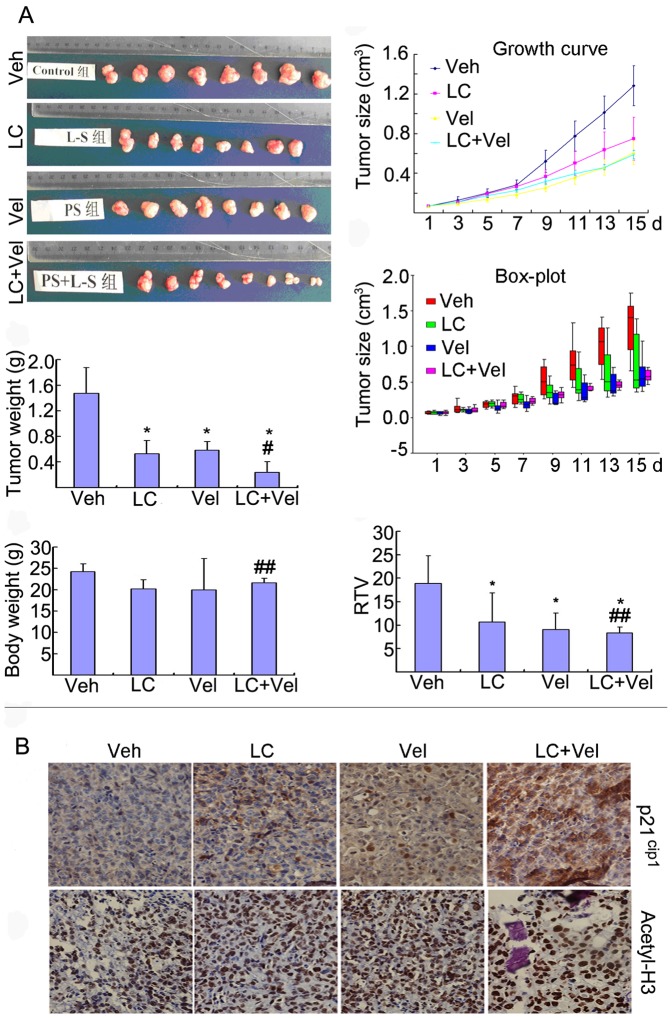
LC and Vel synergistically inhibit cancer growth and increase histone acetylation and p21cip1 expression in vivo.Nude mice bearing HepG2 tumor were i.p injected with vehicle or LC (400 mg/kg, i.p. once/day except day 8), Vel (0.75 mg/kg, i.v. once/3 days) alone and the combination respectively for 15 days. A, Tumor images, tumor weight, body weight, tumor growth curve including Box-plot image and the relative tumor volume in all the four groups (Vehicle-, LC-, Vel- and LC+Vel-) were shown. *P<0.05, compared with the Veh control; #P<0.05, compared with the treatment alone, ##P>0.05, compared with the treatment alone. B, p21cip1 and acetylated H3 proteins in tumor tissues of various groups were detected by immunochemistry and the results were shown respectively. All the immunostaining were repeated in three mouse tumor tissues and the typical images were shown.